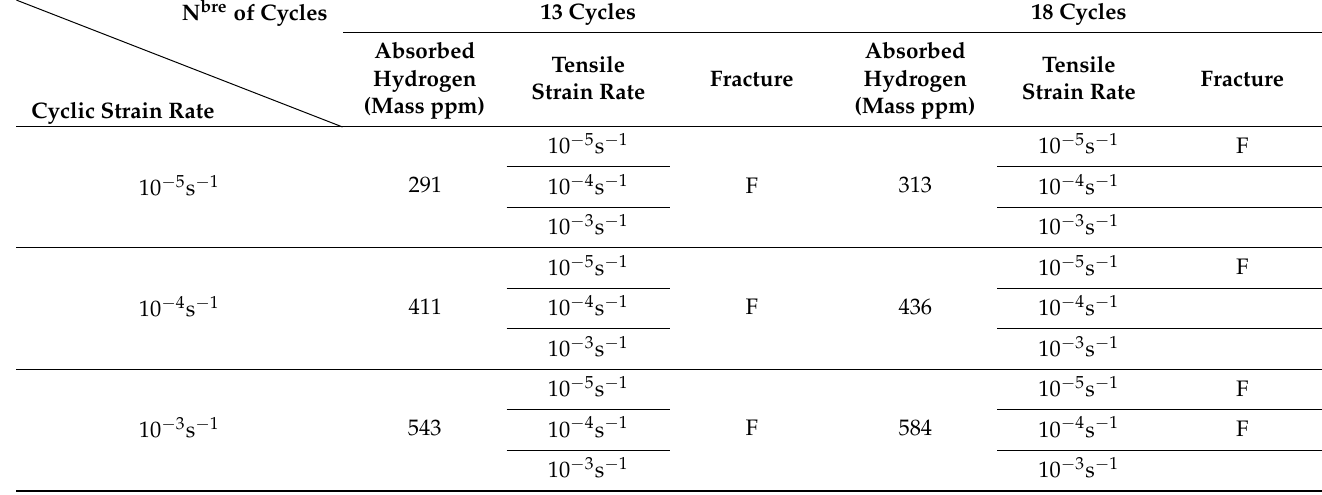
Figure 10. ( a ) Tensile curves obtained after 18 cycles and immersion for 3 h showing the embrittlement of loaded specimen with imposed strain rates of 10 − 5 s − 1 and 10 − 4 s − 1 and superelastic behaviour of loaded specimens with 10 − 3 s − 1 , and ( b ) comparison between critical amount of absorbed hydrogen causing fracture at 10 − 5 s − 1 and quantity of absorbed hydrogen after 18 cycles with 10 − 3 s − 1 and immersion. Table 1. Summary of conducted tensile tests at different strain rates after immersion and cycling with 10 − 5 s − 1 , 10 − 4 s − 1 and 10 − 3 s − 1